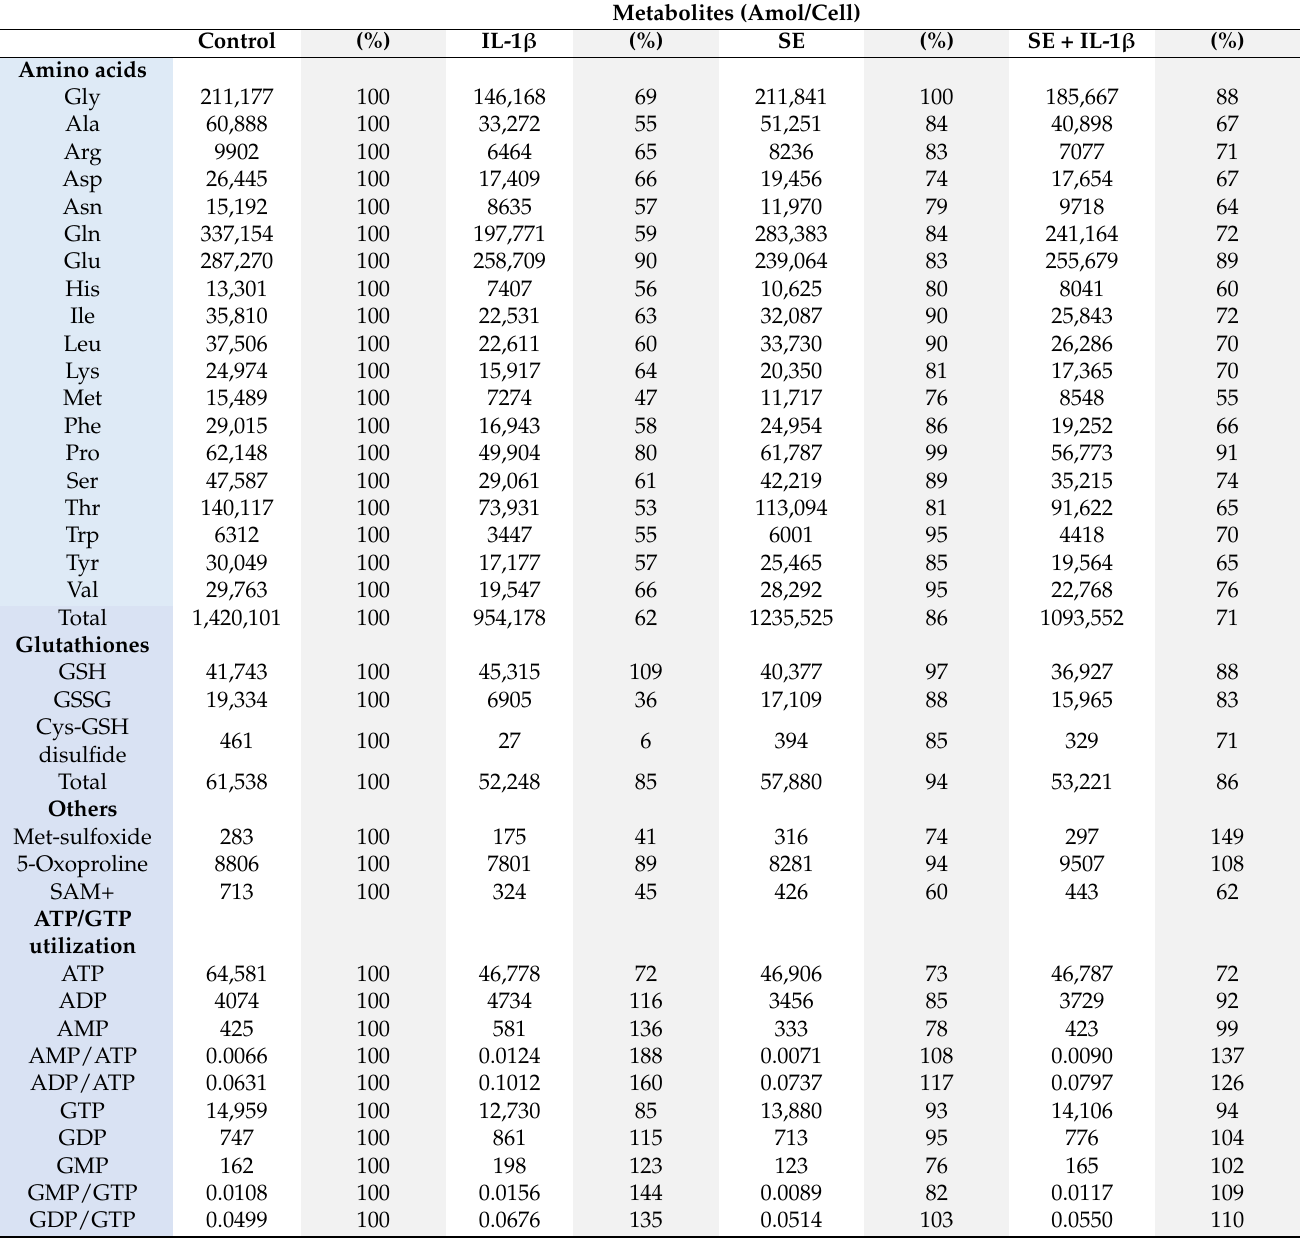
Table 1. Metabolites downregulated by IL-1 β and reversed by SE. Metabolites